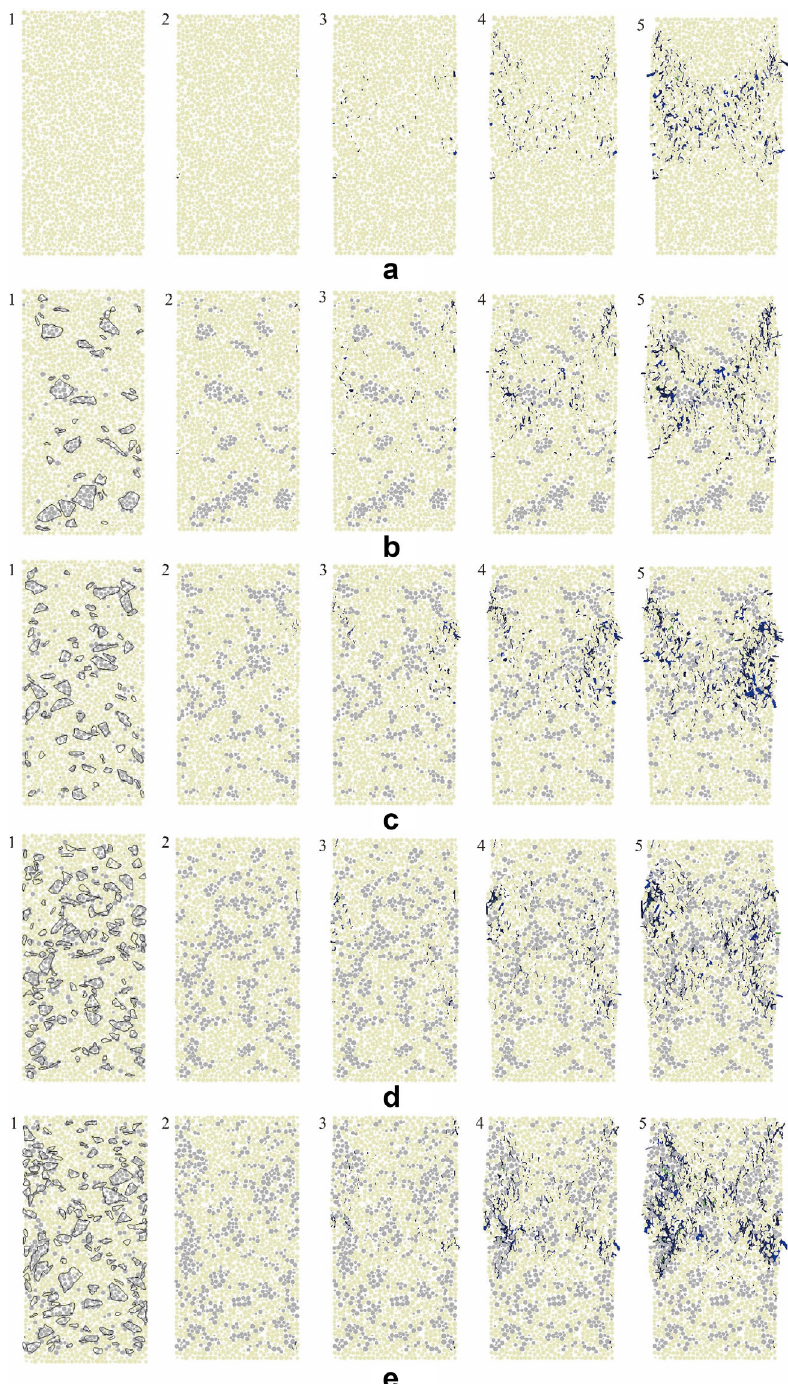
Fig. 18 Vertical sectional representations of 3D crack distribution and growth in PFC3D models of SRM (Light yellow and gray represent soil particles and rock particles, respectively, while the short lines with the other dark color refer to cracks. Rows a – e represent five different rock ratios of 0%, 10%, 20%, 30%, and 50%, respectively. The images from left to right of each row show the crack distribution and growth when the applied load reached the levels of null, peak load, 70% post-peak load, 40% post-peak load and 20% post-peak load. The rock geometries at the unload stage are marked according to the CT